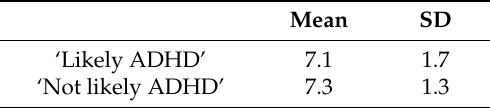
Table 3. Pathological Gambling criteria according to ADHD status.